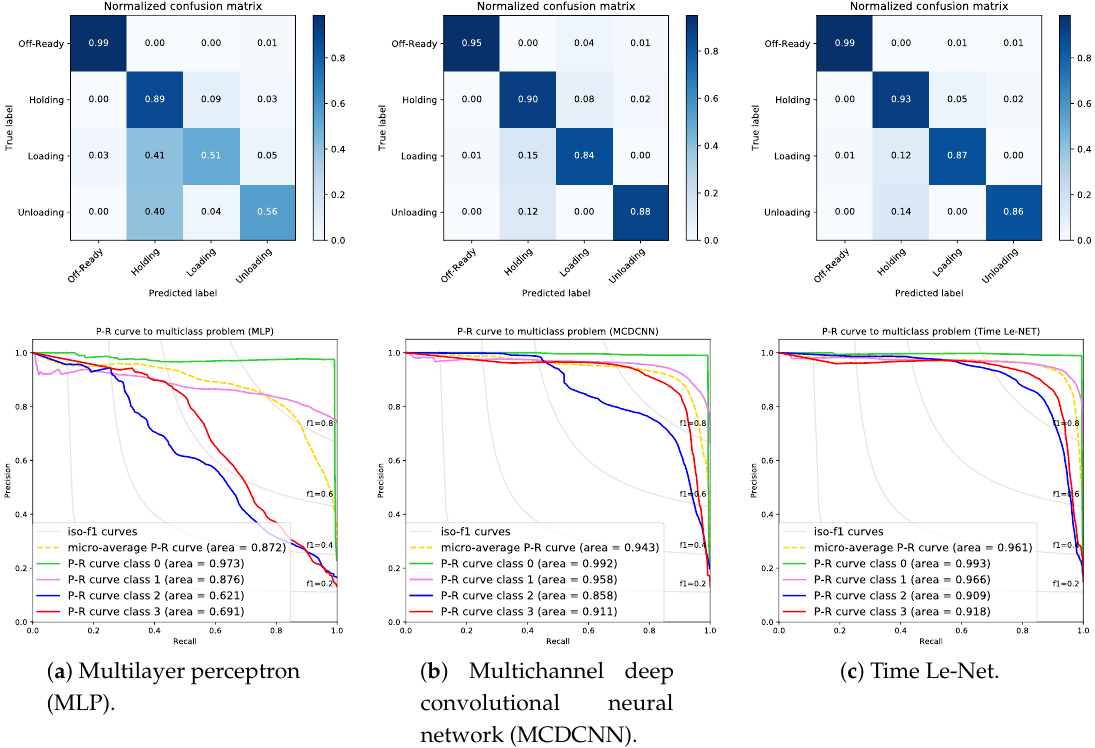
Figure 7. Comparison of the confusion matrices and PR curves using sensor data from compressor 3 (validation